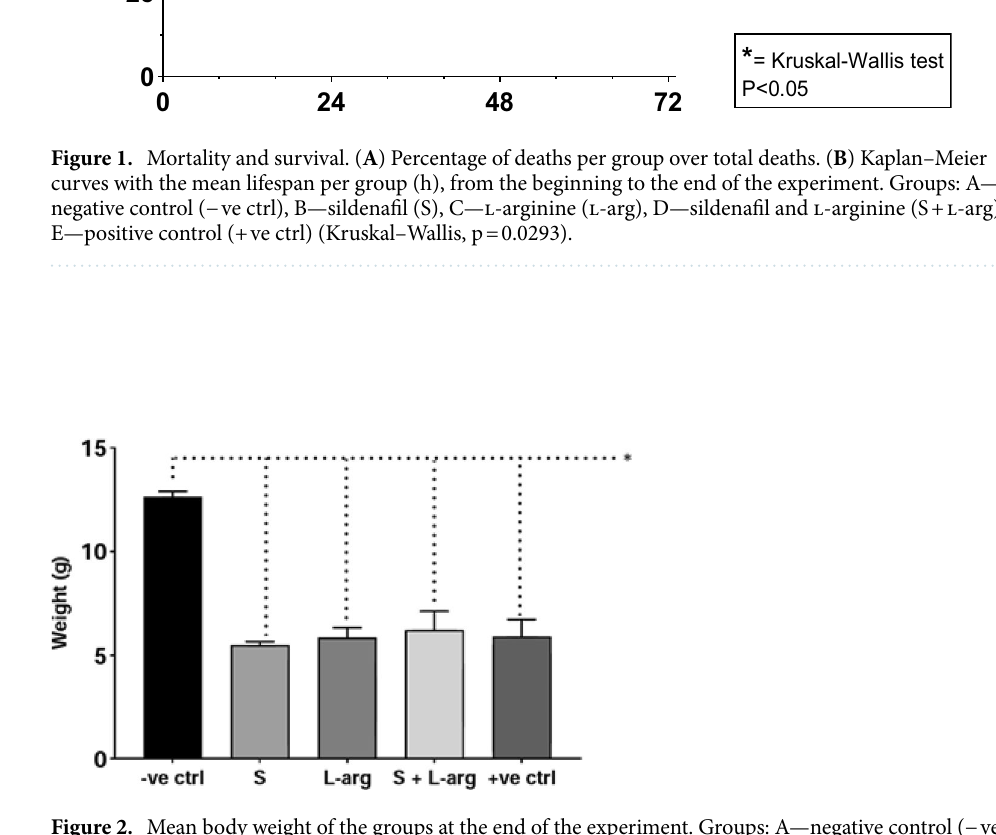
Figure 2. Mean body weight of the groups at the end of the experiment. Groups: A—negative control (− ve ctrl), B—sildenafil (S), C—l-arginine (l-arg), D—sildenafil and l-arginine (S + l-arg) and E—positive control (+ ve ctrl) (Kruskal–Wallis, p =